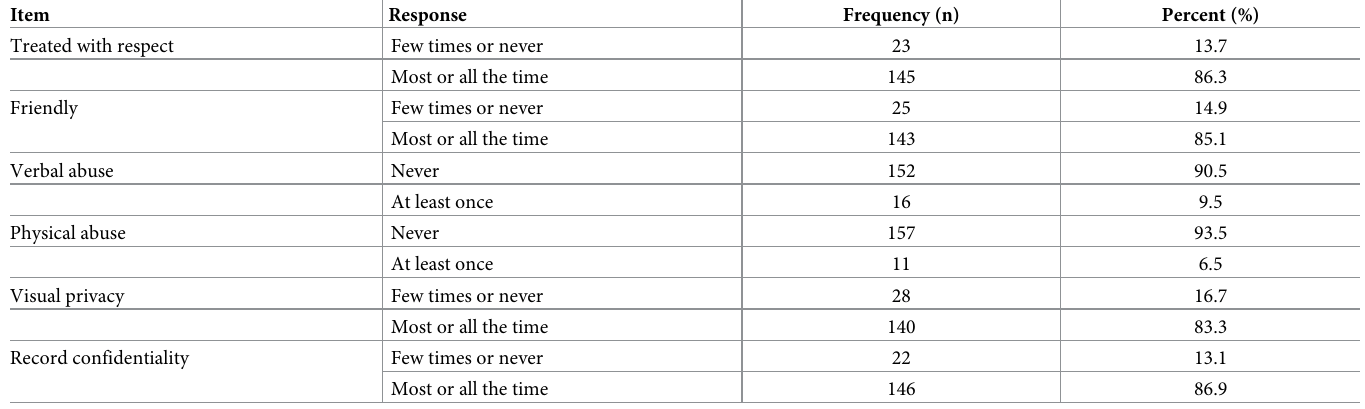
Distribution of supportive care items. Table 4 shows a wide variation in the proportion of midwives who reported good supportive care practices (range,19.0% to 86.3%). Distribution of total person-centred maternity care and subscale. Table 5 shows that few midwives had high perception of PCMC and its subscales. The mean perception of per- son-centred maternity care is 54.06 (10.99). Socio-demographic factors associated with PCMC. As shown in Table 6, there was no socio-demographic differences in total person-centred maternity care and across the sub- scales. Predictors of person-centred maternity care among midwives. Table 7 shows that mid- wives’ perception of PCMC was not significantly related to socio-demographic factors. Table 2. Distribution of dignity and respect items among